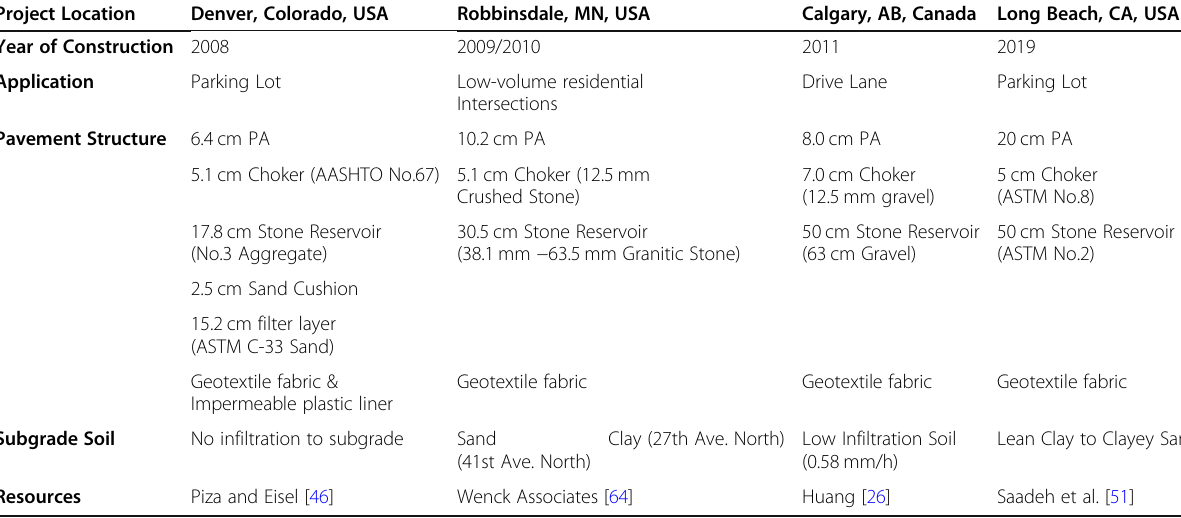
Table 2 Selection of aggregate size for choker course Project